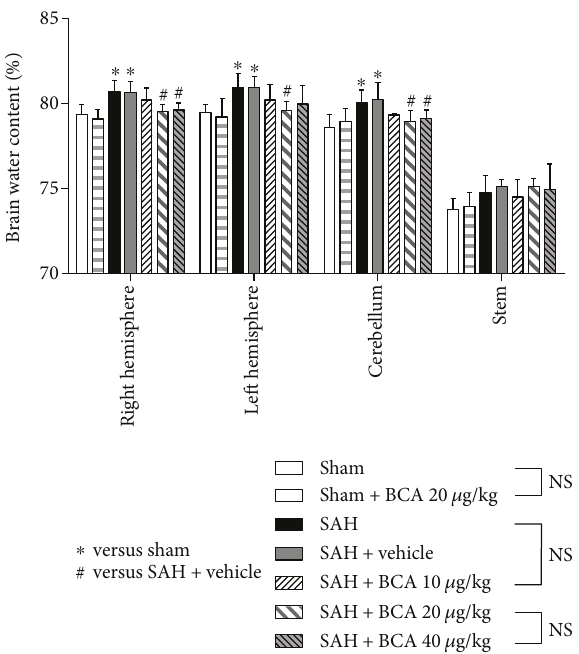
Figure 3: The e ff ects of BCA on the brain water content levels in the left hemisphere, right hemisphere, cerebellum, and brain stem at 24h post SAH ( n = 6 , each group; ∗ P < 0 05 versus sham; # P < 0 05 versus SAH+vehicle; NS P > 0 05